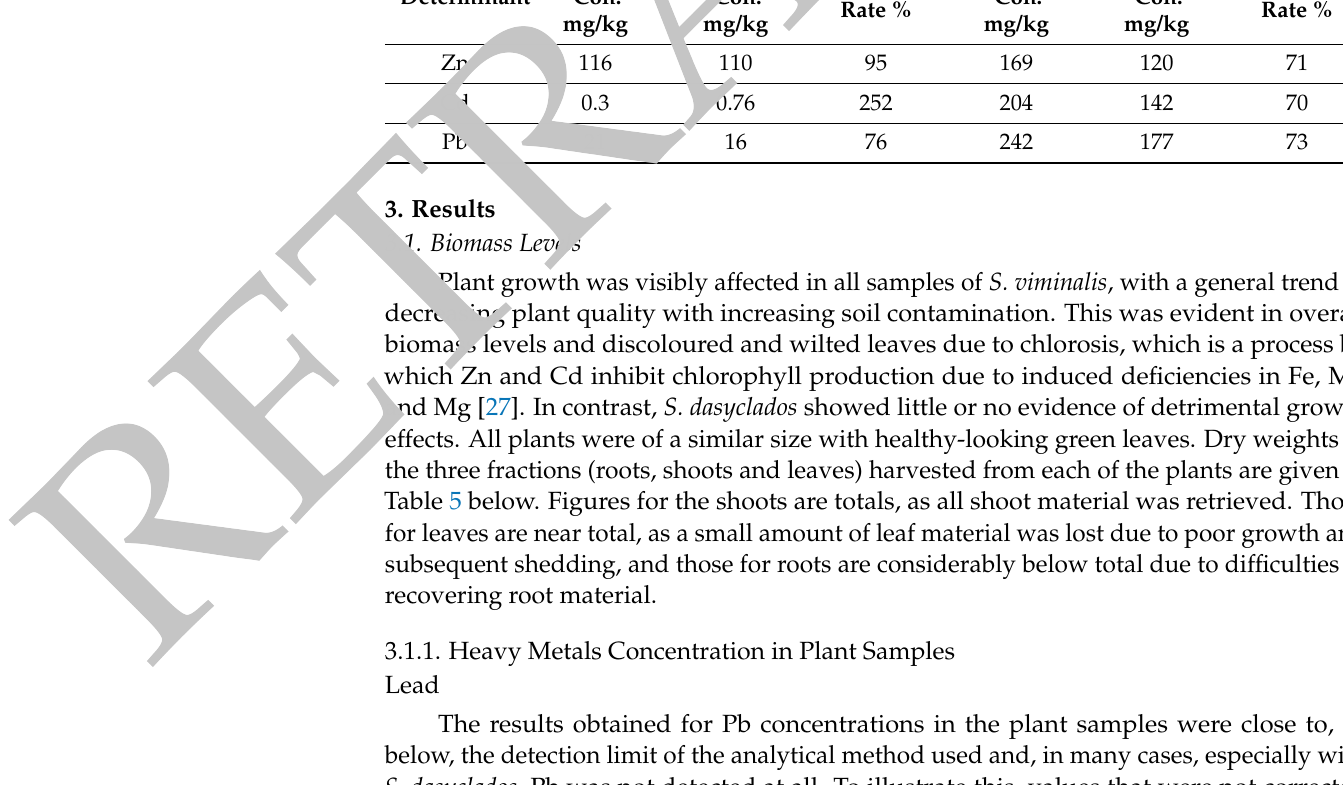
Table 4. Data used for determination of accuracy of analytical methods considering relevant reference materials (Canmet Till 2 and IEAE413